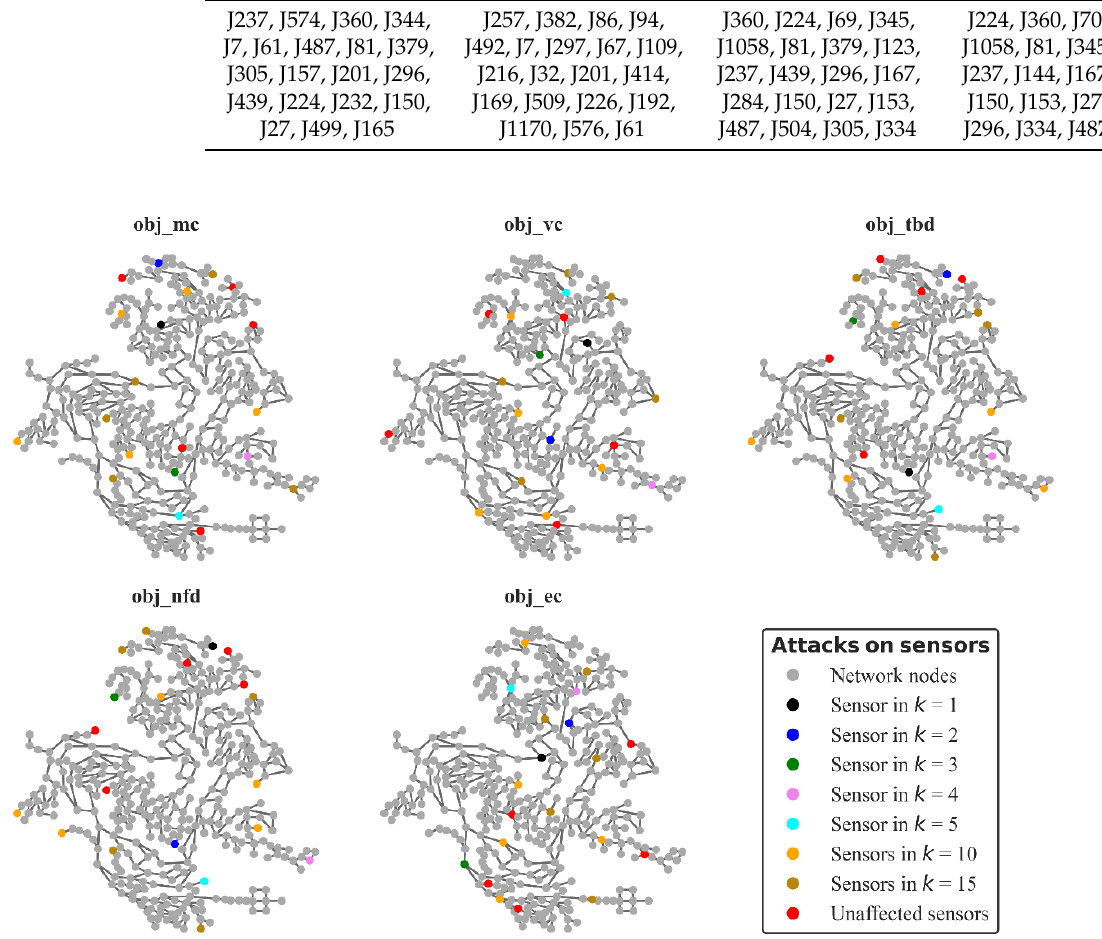
Figure 7. Topologies of 20 sensors as placed by the objective functions used in this work, color coded by the set of 𝑘 attacks they belong to (some representative sets are selected).